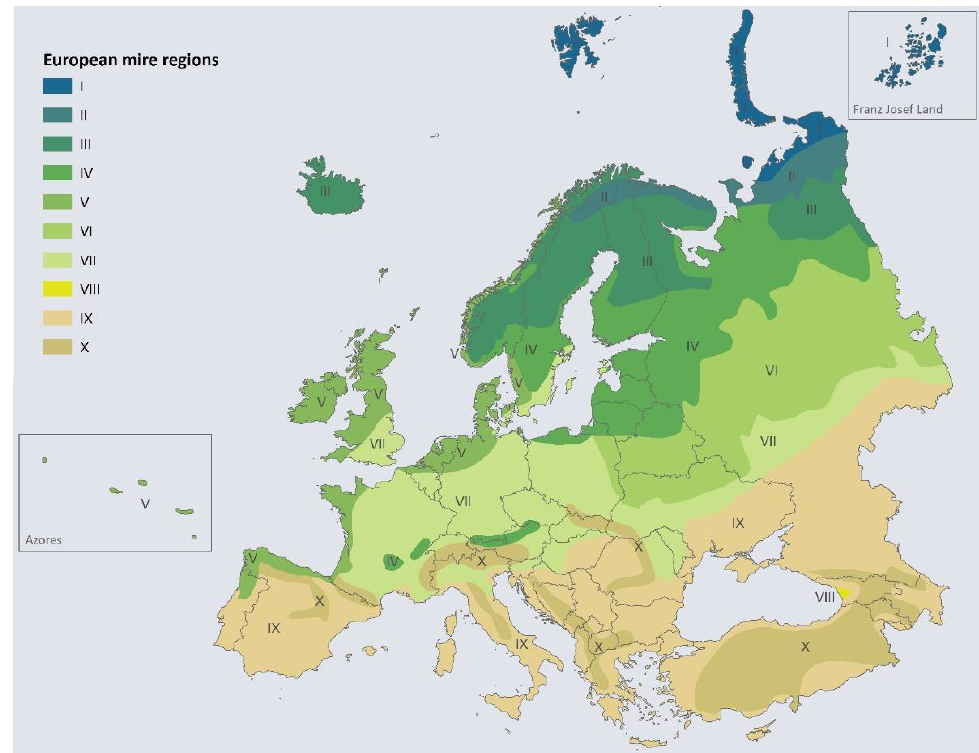
Figure 1. The ten European mire regions (simplified from [27]). (I) Arctic seepage and polygon mire region, (II) palsa mire region, (III) northern fen region, (IV) typical raised bog region, (V) Atlantic bog region, (VI) continental fen and bog region, (VII) nemoral-sub-meridional fen region, (VIII) Colchis mire region, (IX) southern European marsh region, (X) central and southern European mountain compound region.